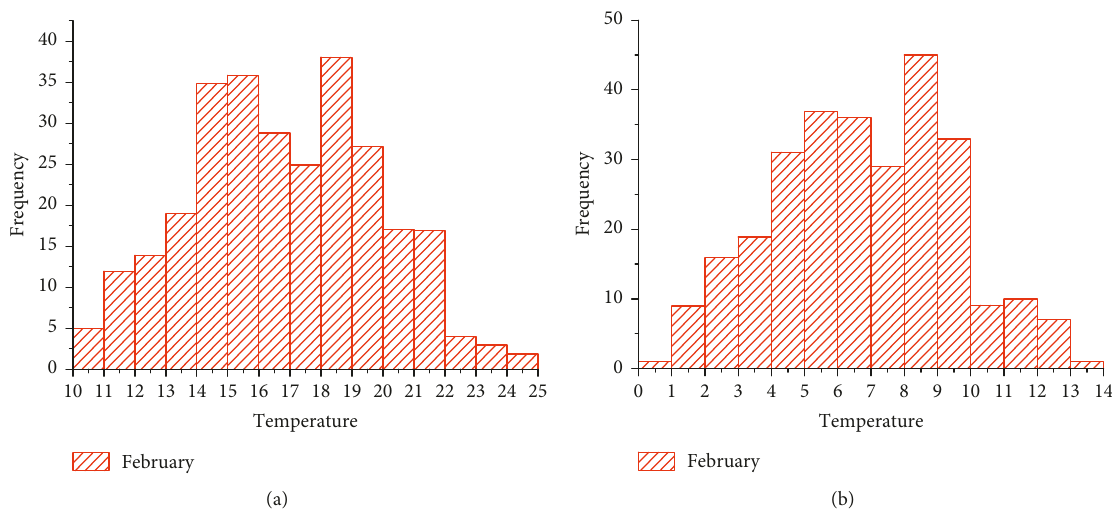
Figure 2: The histogram of the daily extreme value of axial uniform temperature in February. (a) The maximum. (b) The minimum.